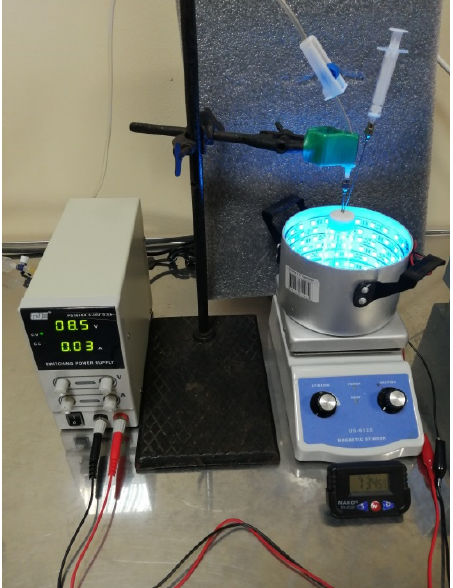
Figure 2. Experimental set-up for the photoiniferter